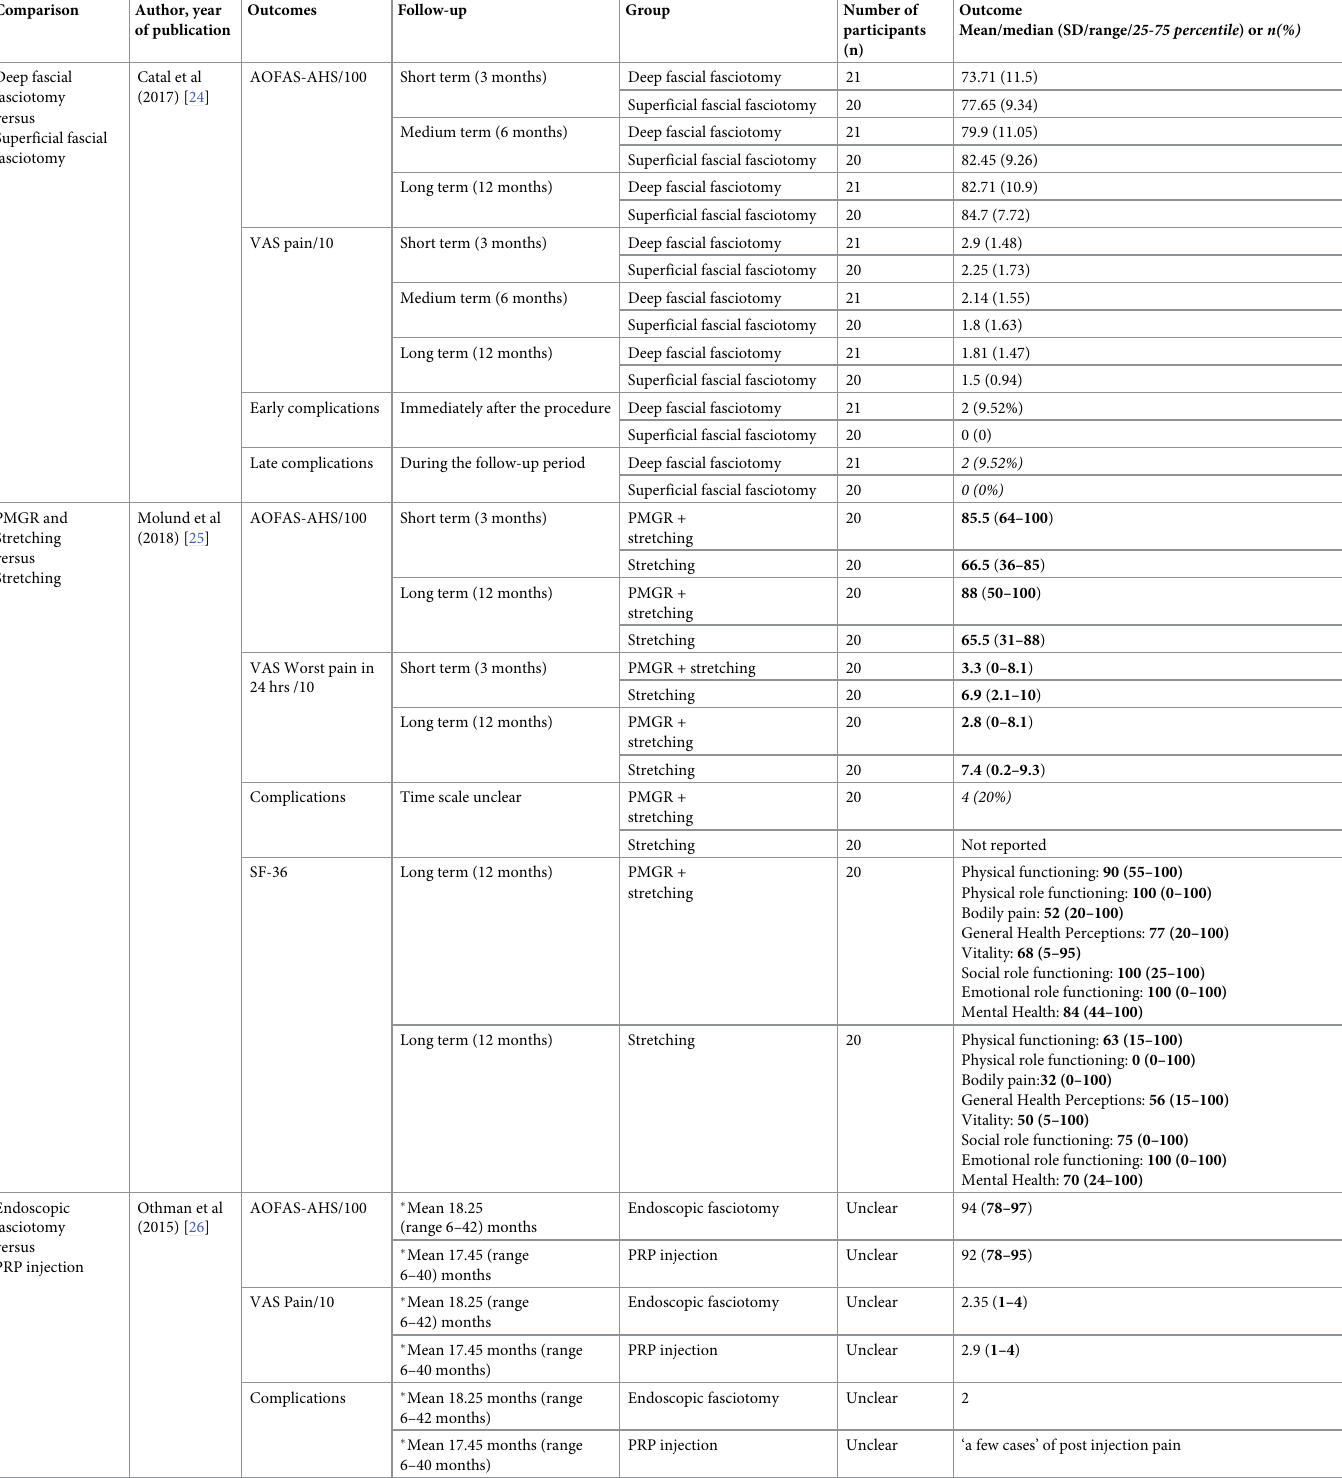
Table 2. Results of included